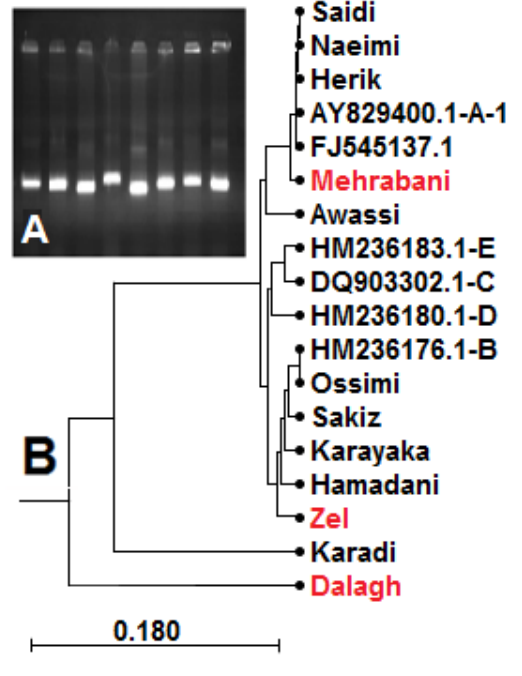
Figure 1. (A) Electrophoresis of polymerase chain reaction products on 1 % agarose gel showed amplified fragments of 1075 bp. (B) Phylogenetic tree of the control region between the studied breeds (1, 2, and 3) and various Middle Eastern breeds with different haplotypes of sheep. Mehrabani sheep breed was observed among A haplotype breeds while Zel among B